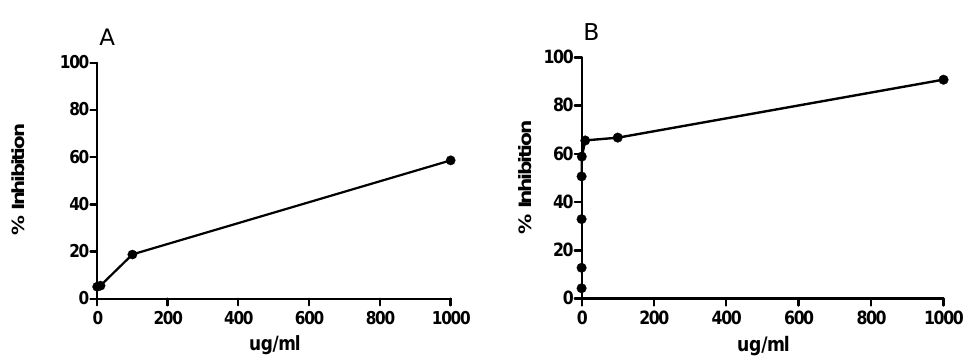
Figure 8. In vitro pancreatic lipase ( A ) and amylase ( B ) inhibition by AERM. Experiment was performed in triplicate. IC 50 was calculated from curves using GraphPad Prism Software.